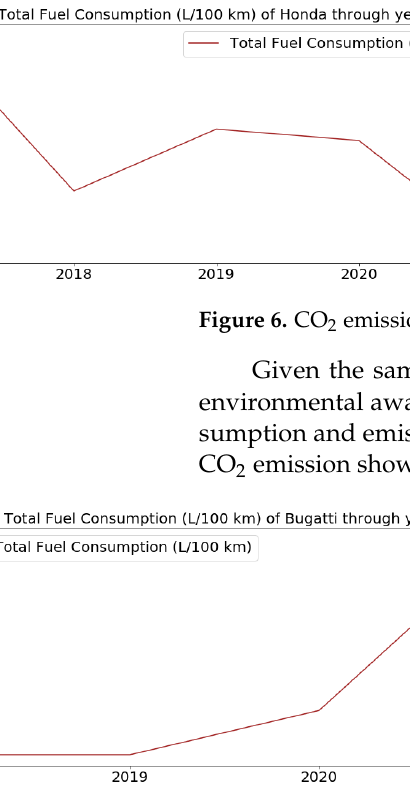
Figure 7. CO 2 emissions (g/km) and total fuel consumption (L/100 km) of Bugatti over